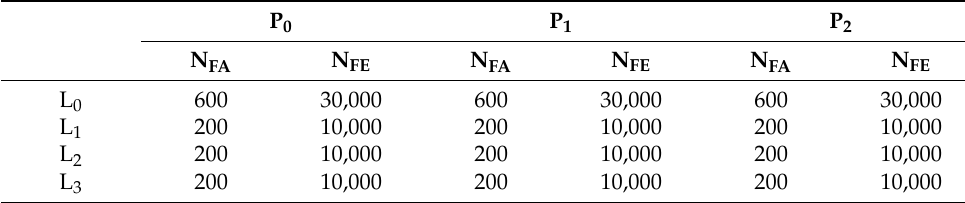
Table 2. Number of datasets used for the offline analysis and evaluation.